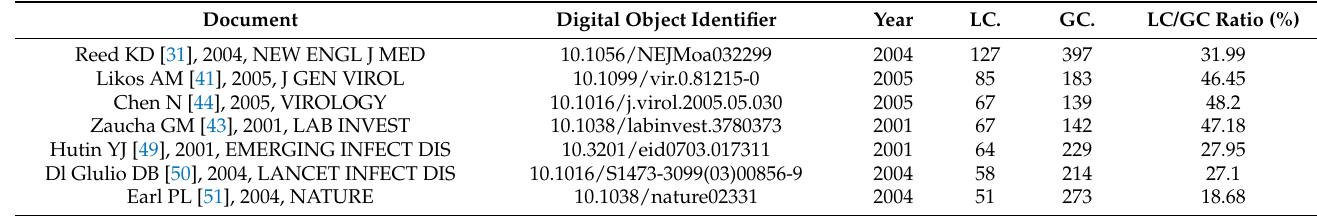
Table 4. The top 20 locally cited